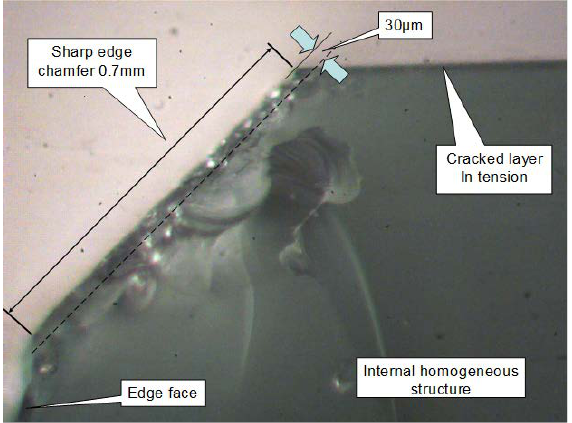
Fig.3 The source of fracture - a long microcrack depth of 30 microns on a ground surface of a chamfer